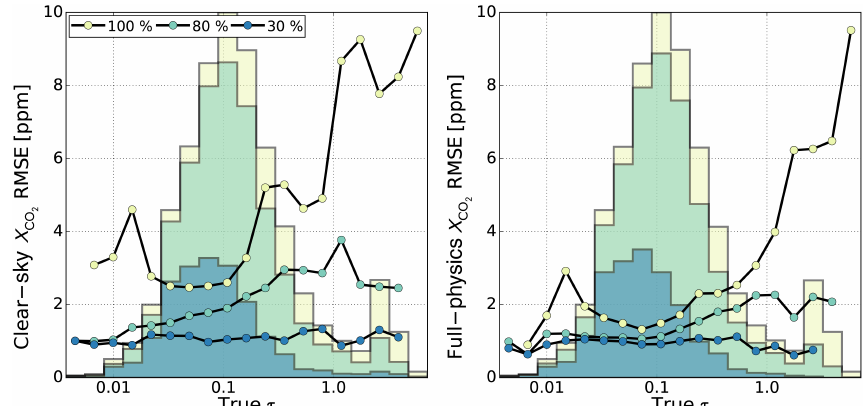
RMSEs vs. the true total optical depth for simulated OCO-2 measurements 2 RMSE for 100% throughput (yellow markers), 80% throughput (green markers), 2